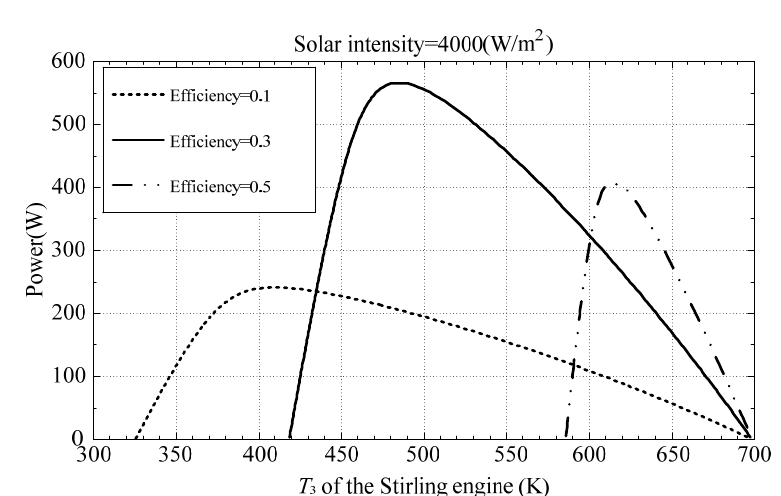
Figure 5. Engine output